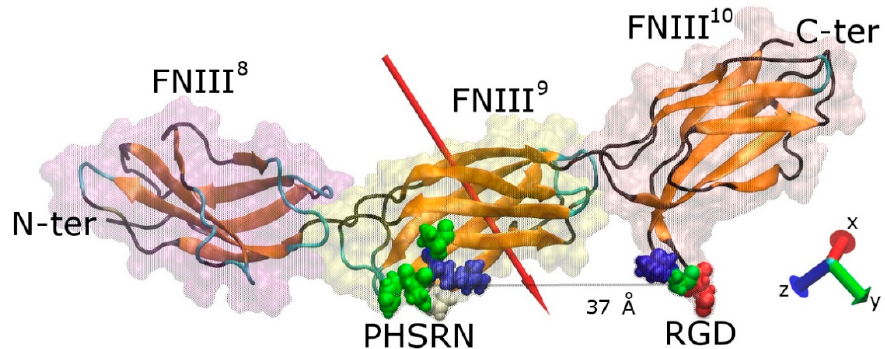
Figure 1. Graphical representation of a FNIII 8–10 fragment of fibronectin. The secondary structure (colour-coded; orange, teal, and black represent β -sheets, loops, and coil, respectively) along with the protein “ghost” surface of the modules that comprise the fragment are visible. The cell binding (RGD) and synergy (PHSRN) sites, as well as the distance between them, are shown, and the red arrow indicates the dipole moment of the fragment. The amino acids shown are colour-coded with blue, red, white, and green representing positively charged, negatively charged, hydrophobic, and polar uncharged, respectively. For sake of clarity, the water molecules are not shown.